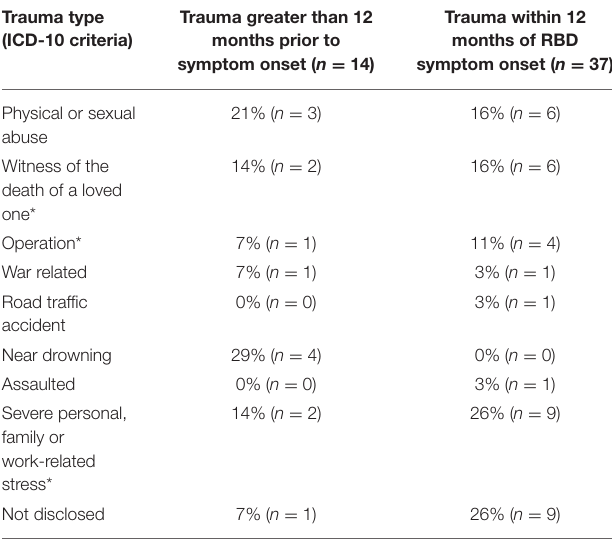
TABLE 1 | Type of traumatic event and time at which it was experienced in relation to iRBD onset. Trauma type (ICD-10